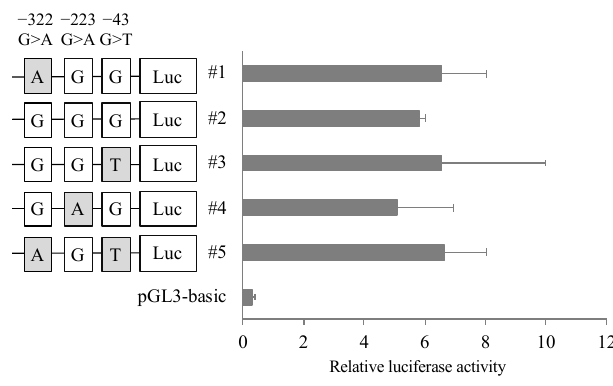
Figure 3. Reporter gene activities of Cathepsin A 5 ′ -FLR. Luciferase reporter gene vectors containing each polymorphisms were transfected into the K562 cells. Relative luciferase activity of each reporter vector is Firefly luciferase activity normalized to Renilla luciferase activity. The data represented as mean + S.D. of triplicate experiments.